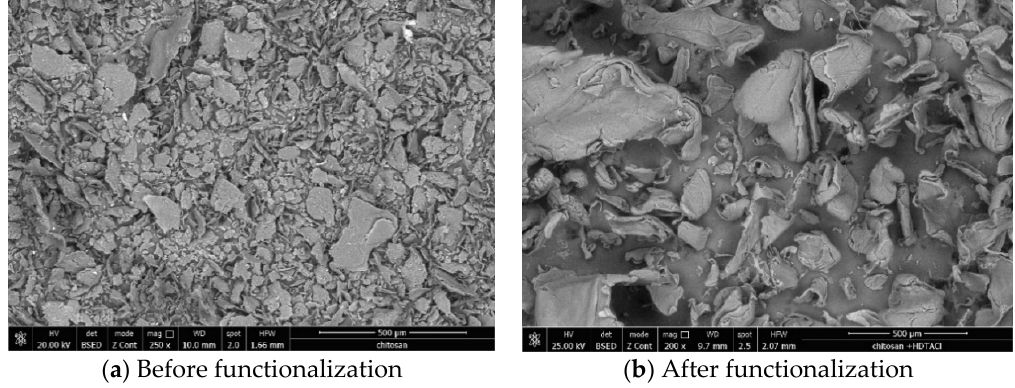
Figure 1. X-ray dispersion (EDX) spectra of unfunctionalized and functionalized bio material. Figure 2. Scanning electron microscopy before ( a ) and after ( b ) biomaterial functionalized.